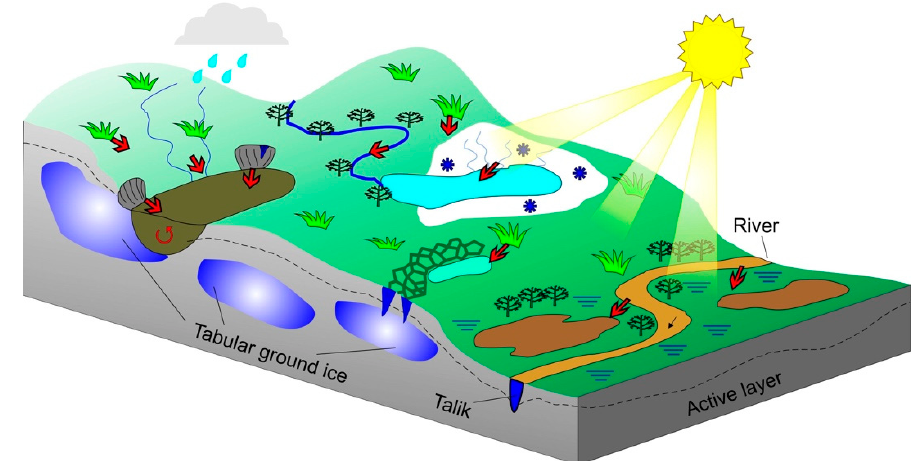
Figure 6. Theoretical scheme of the organic matter transport in Central Yamal lakes. Lakes are shown in different colors: thermocirque-impacted and floodplain lakes are more colored (brownish color) representing higher CDOM concentration. Red arrows represent the ways of organic matter transport to lakes from surrounding catchments.